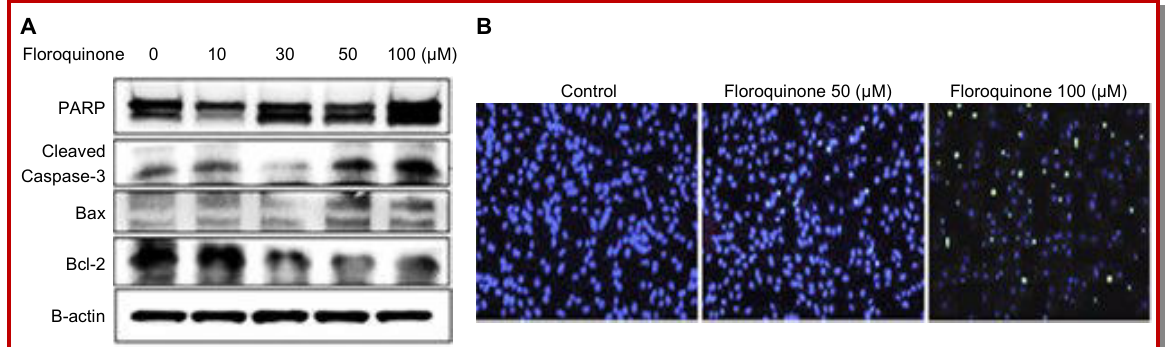
Figure 1: Floroquinone treatment for 48 hours inhibits growth of HOTHC and FRO ATC cell lines in concentration based manner. The cells were incubated for 48 hours with floroquinone followed by analysis using MTT assay. The data presented are the mean of three experiments performed independently